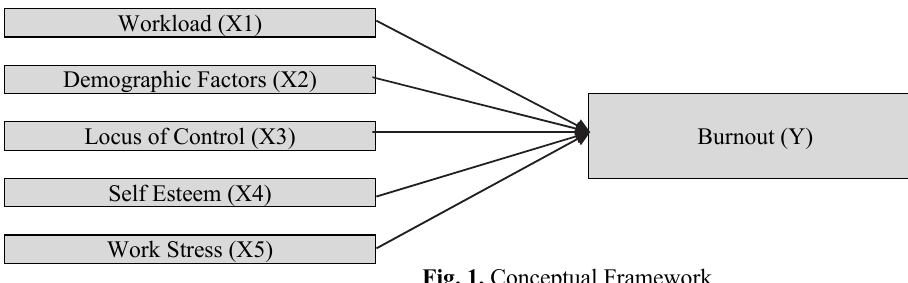
Fig. 1. Conceptual